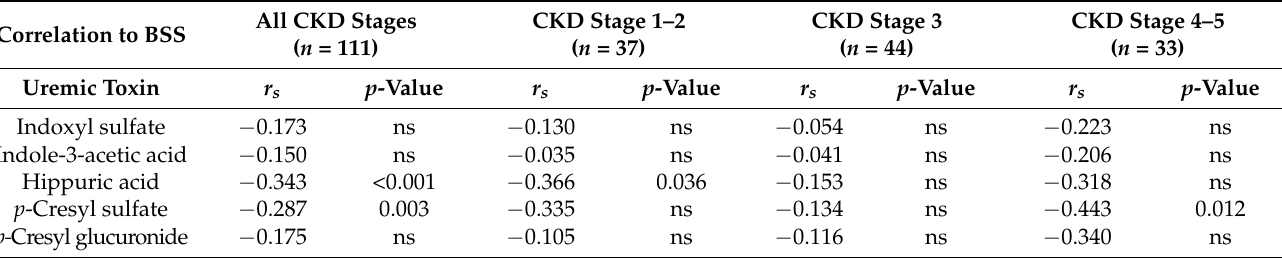
Table 1. Correlation between intestinally generated uremic toxins and transit time of patients with CKD.